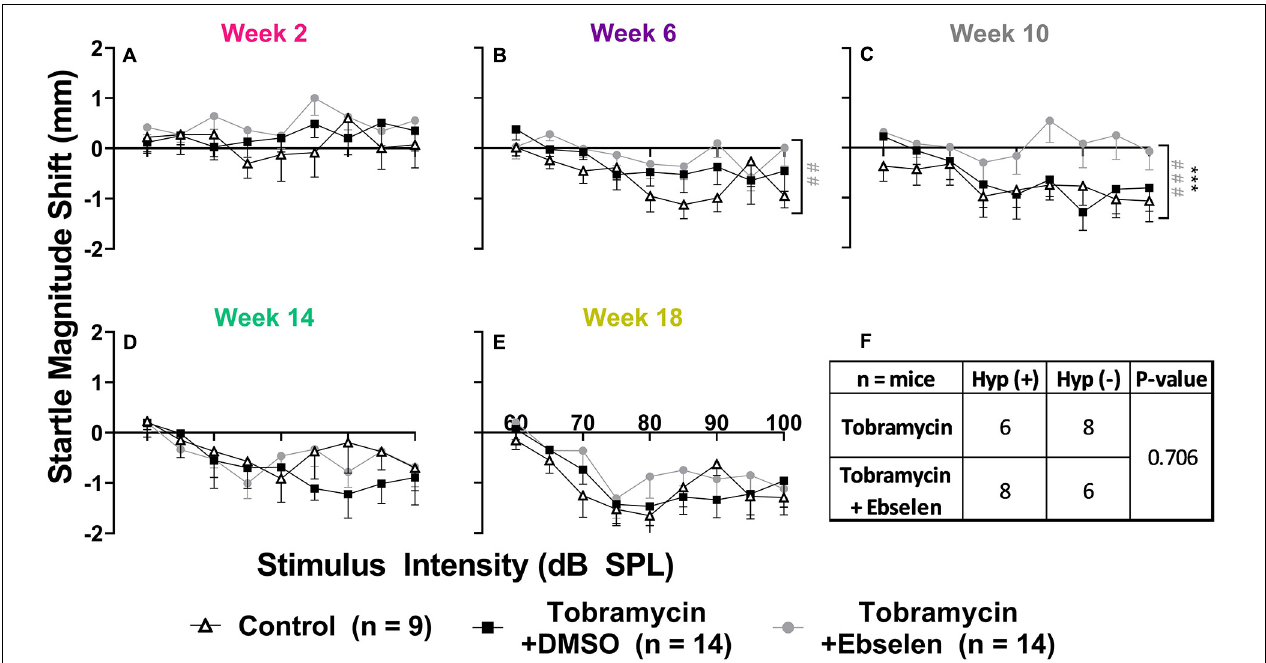
FIGURE 5 | Evaluation of behavioral evidence of hyperacusis by dosing group. Averaged tobramycin-induced IO stimulus/response functions shifts comparing testing groups at different epochs ( (A): week 2, (B): week 6, (C): week 10, (D): week 14, (E): week 18) after the start of treatment. Startle response magnitude CMD (mm) as a function of stimulus intensity (60 to 100 dB SPL) represent each specific epoch minus baseline. The value 0 on the y-axis represents no change from baseline startle reactivity. Data is represented by means and standard errors. Post hoc tests determined significant differences between testing groups, which are indicated as follows: # (black), between control and DMSO treated animals; # (gray), between control and ebselen treated animals; *, between DMSO and ebselen treated animals. (F): Contingency table for the development of hyperacusis which shows the number of mice which met or did not meet the criteria for hyperacusis (significant increase in startle IO function at any epoch when compared to baseline). Each animal was analyzed independently. Two-sided Fisher’s exact tests were used statistically evaluate differences between tobramycin dosed